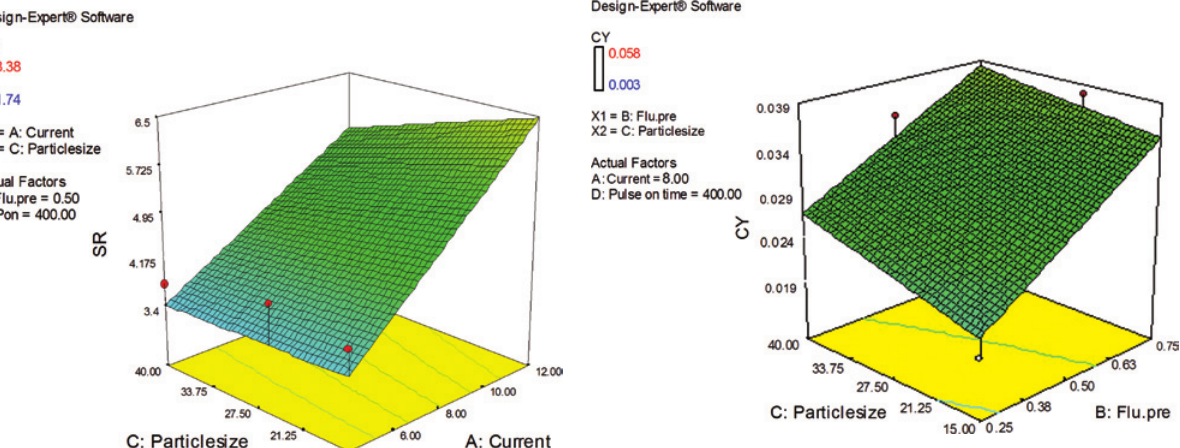
Figure 12 Interactive effect of flushing pressure and particle size on